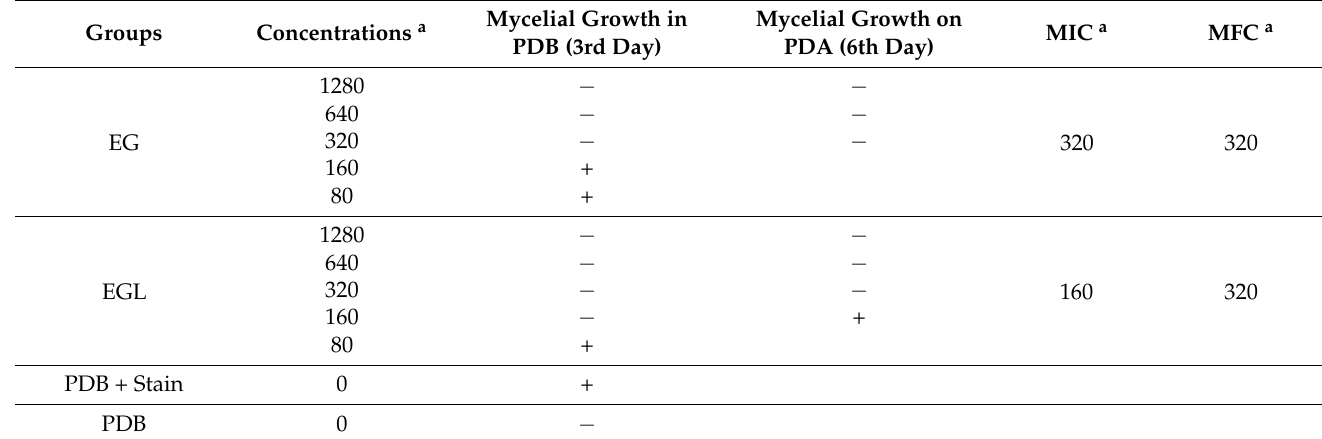
Table 1. MIC and MFC of EG and EGL nanoemulsions against P. italicum.